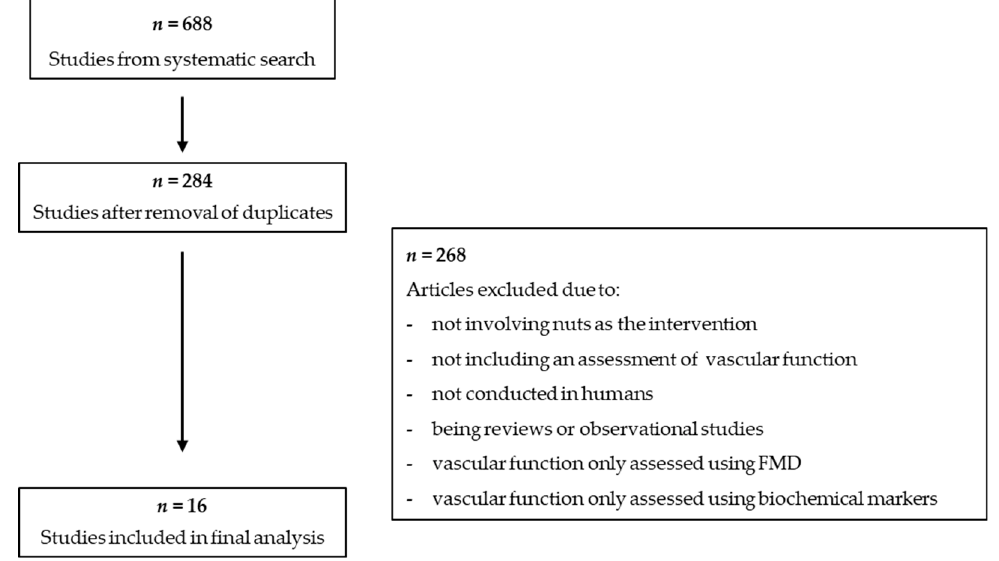
Figure 1. Flowchart of study selection process.